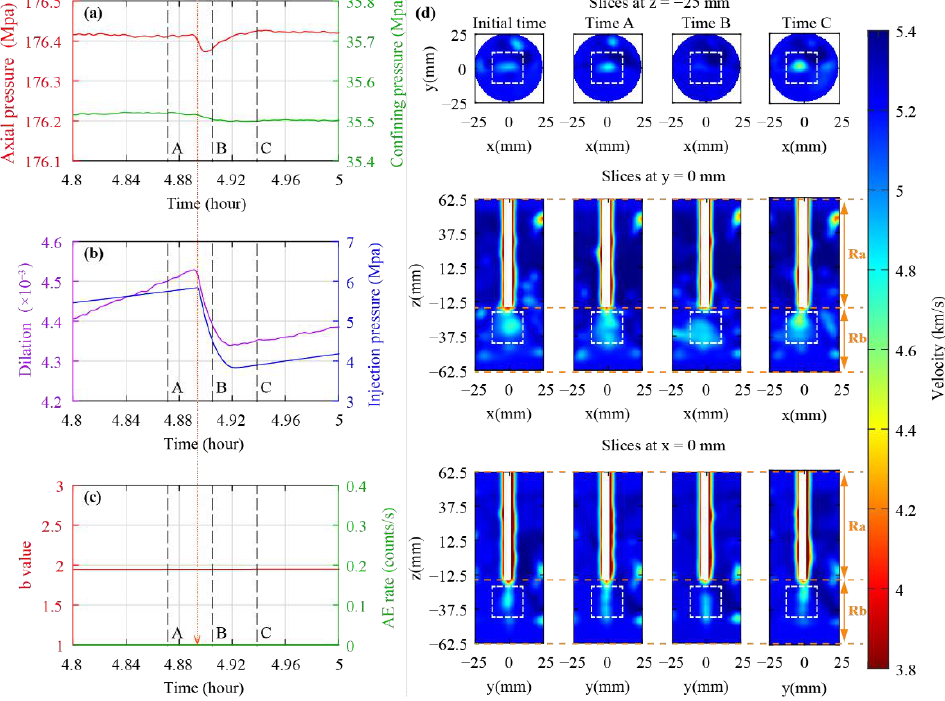
Figure 9. Mechanical response and velocity images of rock in H0 phase: ( a ) axial (red line) and confining pressure (green line); ( b ) dilation (purple line) and water injection pressure (blue line); ( c ) b-value (red line) and AE rate (green line); ( d ) slices of the 3D ultrasonic velocity images at different times (the initial time refers to the time when H0 starts, and the times A – C correspond to the times marked by black dotted lines in the left subfigure). The orange dotted line in the left picture marks the moment when pore pressure starts to drop. The orange dotted line in the subfigure (d) represents the boundary between region Ra and Rb. The white dotted line box represents the low-velocity zone below the borehole.